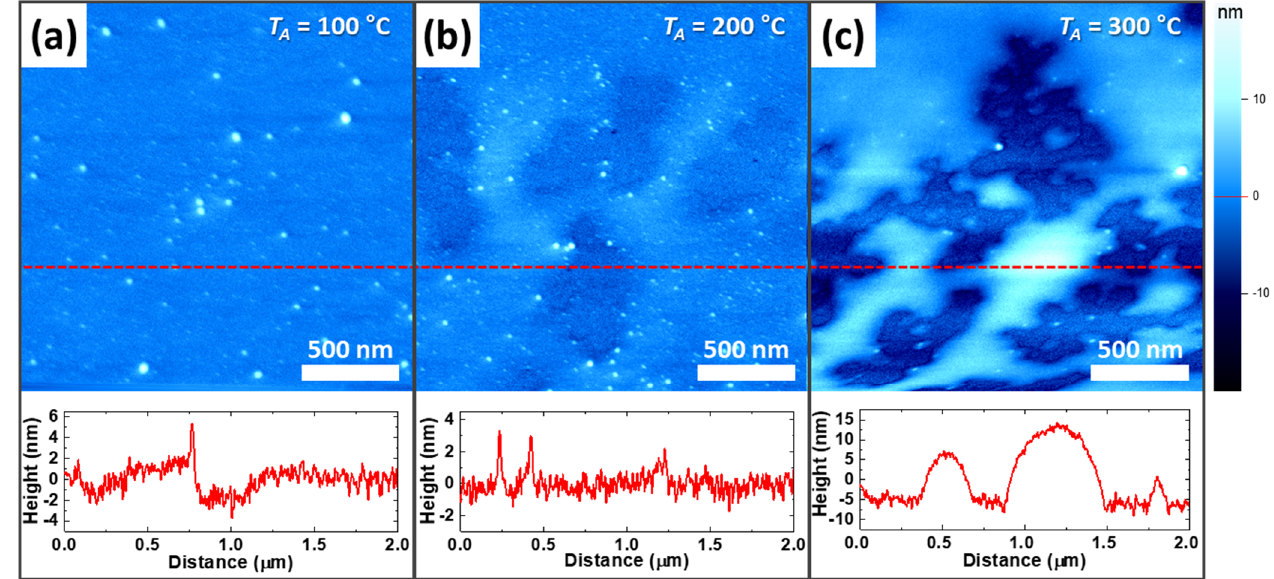
Figure 4. Atomic force microscopy (AFM) surface analysis of Cytop-coated Si substrate. AFM mappings and height graphs of Cytop-coated Si substrate annealed ( a ) at T A = 100 °C, ( b ) at T A = 200 °C, and ( c ) at T A = 300 °C.